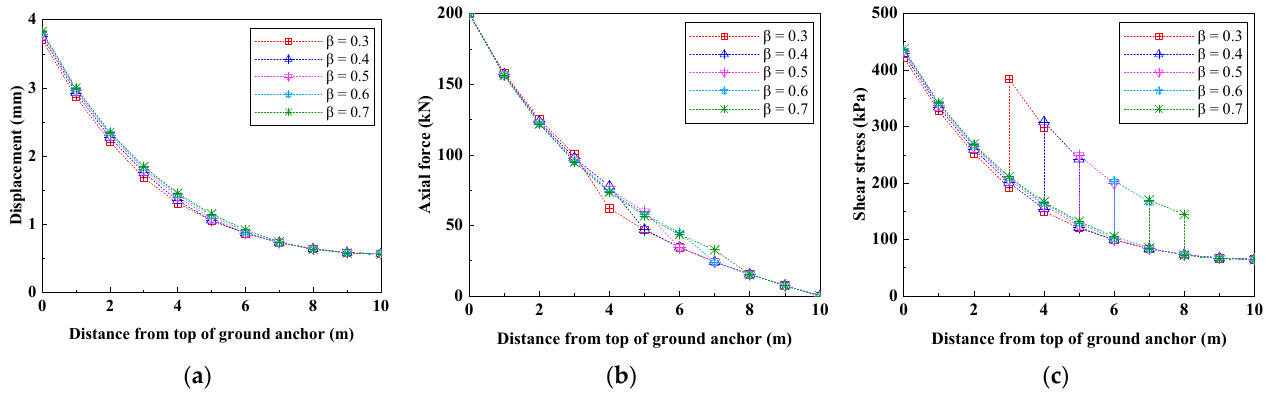
Figure 12. Effect of the depth of stratum interface on mechanical behavior of ground anchor. (Case 2: condition 3) ( a ) displacement distribution curve; ( b ) axial force distribution curve; ( c ) shear stress distribution curve.